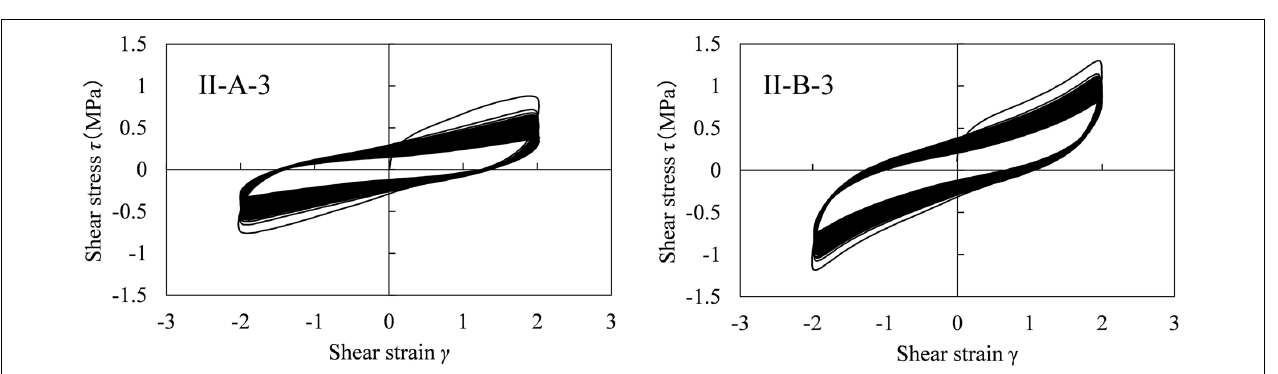
FIGURE 9 | Shear stress-strain relationship of scale- II-A and -II-B under repeated loading for shear strain 200% × 200